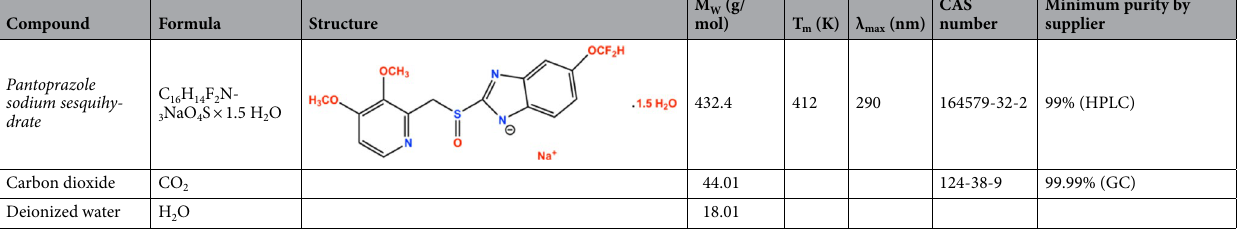
Table 1. Chemicals used in the work and its details.